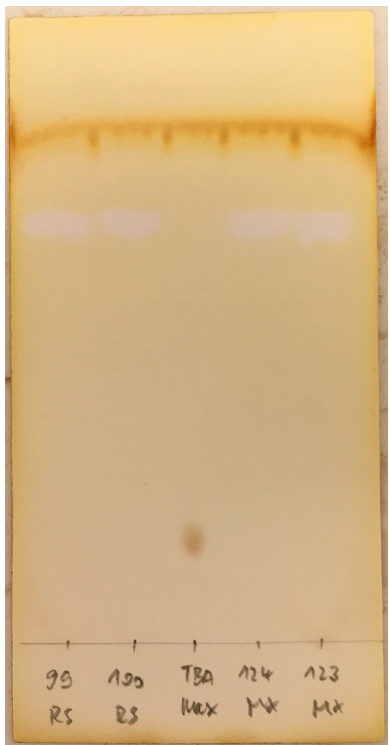
Figure 3. Iodine-stained TLC from the tetrabutylammonium (TBA) test showing the reference solution 0.1 mg/mL in the middle and respective final solutions from TRACERlab MX (left) and mosaic-RS (right).